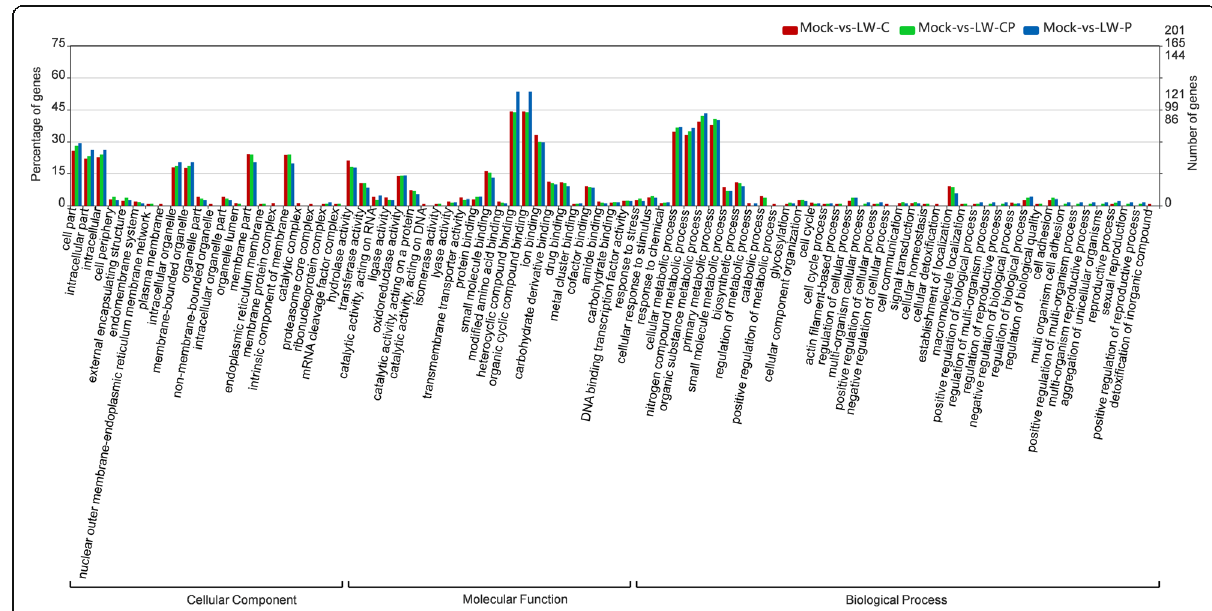
Fig. 10 WEGO functional enrichment analysis of predicted Bd -milRNA target genes in mycovirus-infected Botryosphaeria dothidea LW-Hubei strains including of three comparisons between LW-CP vs. Mock (green), LW-C vs. Mock (red), and LW-P vs. Mock (blue) libraries, respectively. X axis represents GO term; Y axis represents number (percentage) of